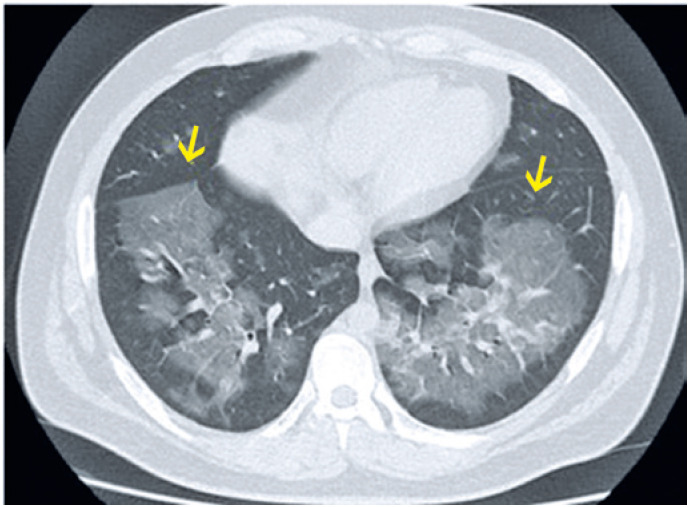
Homem, 24 anos, com queixa de dispneia e tosse. Refere uso de
vaping
. Tomografia computadorizada (axial): opacidades em vidro foco de distribuição peribroncovascular difusa, com predomínio nas bases pulmonares, associadas a espessamento de paredes brônquicas e, por vezes, espessamento dos septos interlobulares, além de pequenas áreas de consolidação de permeio nas bases